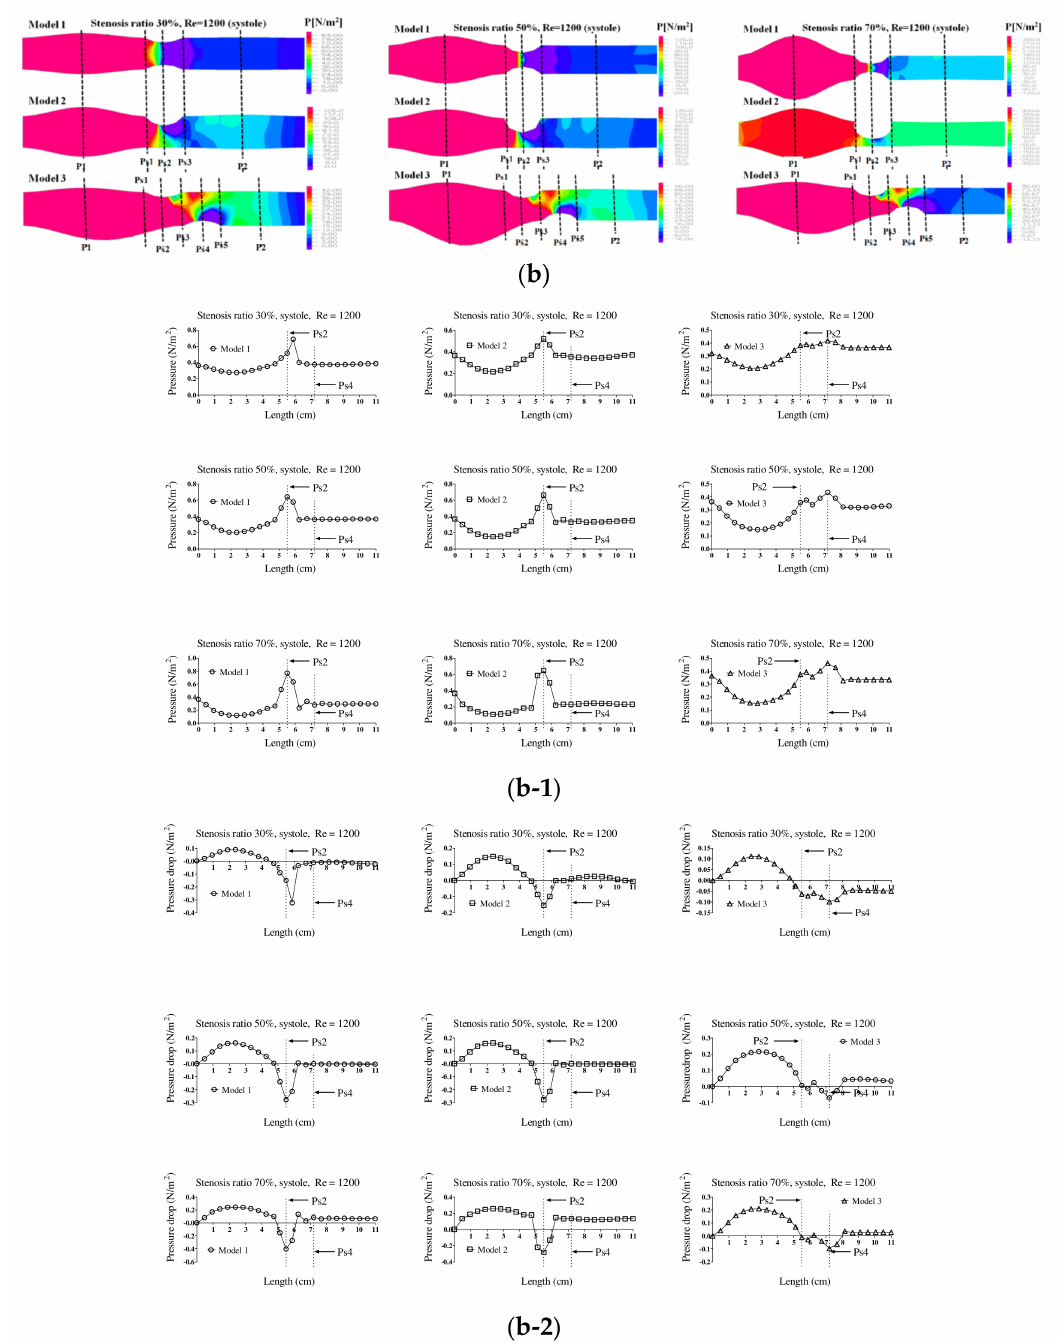
Figure 4. The pressure distribution, the average pressure, and pressure drop in the pulsatile flow field based on changes to the stenosis ratio at each point of the modules. Diastolic ( a ) pressure distribution, ( a-1 ) average pressure, and ( a-2 ) pressure drop; systolic ( b ) pressure distribution, ( b-1 ) average pressure, and ( b-2 ) pressure